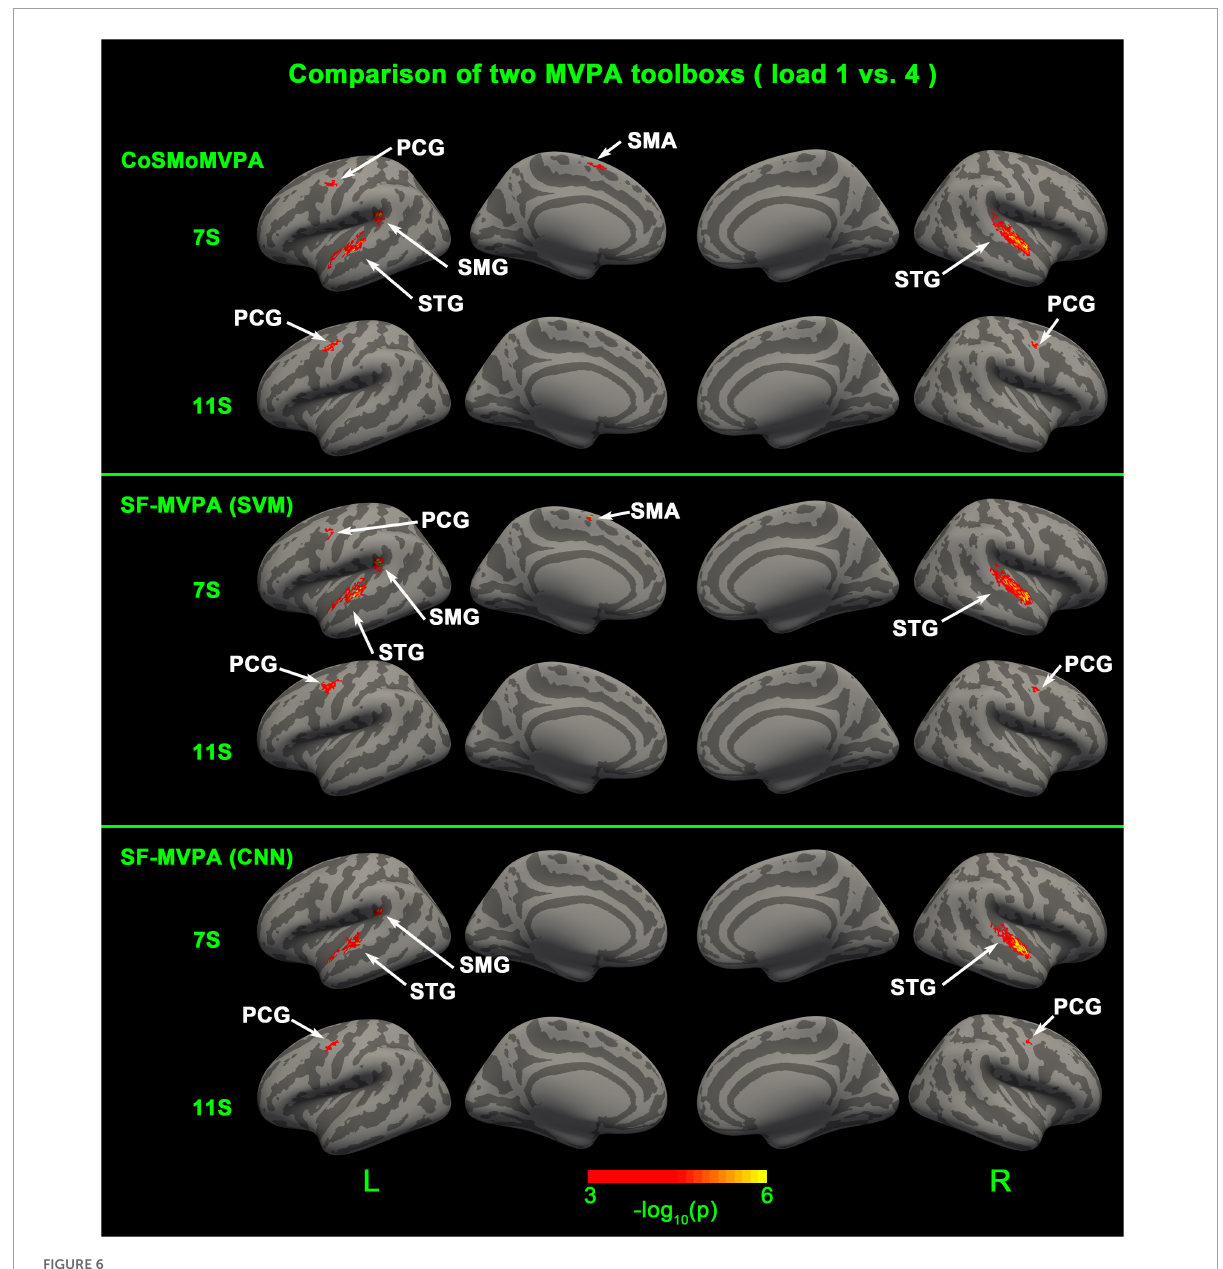
FIGURE6 Surface space-based multivariate pattern analysis (MVPA) results (load 1 vs. load 4) of CosMoMVPA, SF-MVPA (SVM), and SF-MVPA